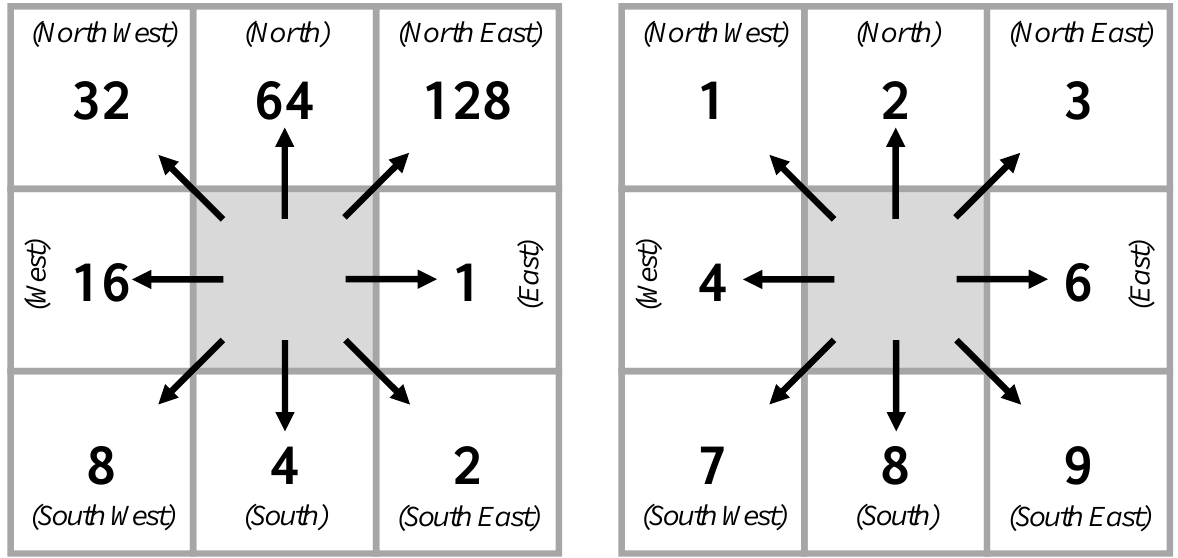
Figure 8. Comparison of D8 ESRI flow direction and D8 TopoIndex flow direction.